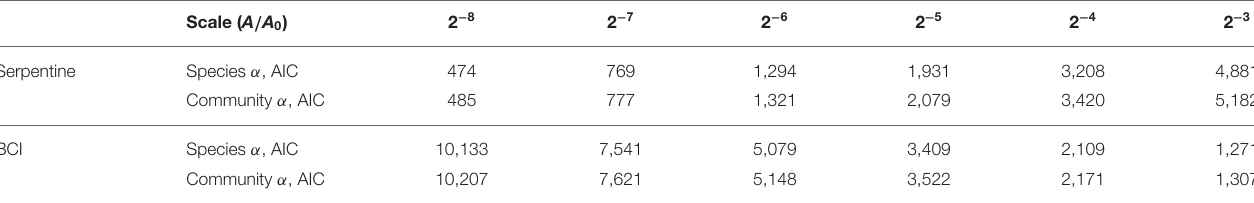
TABLE 2 | Comparison of the Akaike Information Criterion (AIC) for α defined at the individual species level and at the community level in both the serpentine and BCI data and across scales. Scale ( A / A 0 ) 2 − 8 2 − 7 2 − 6 Serpentine Species α ,